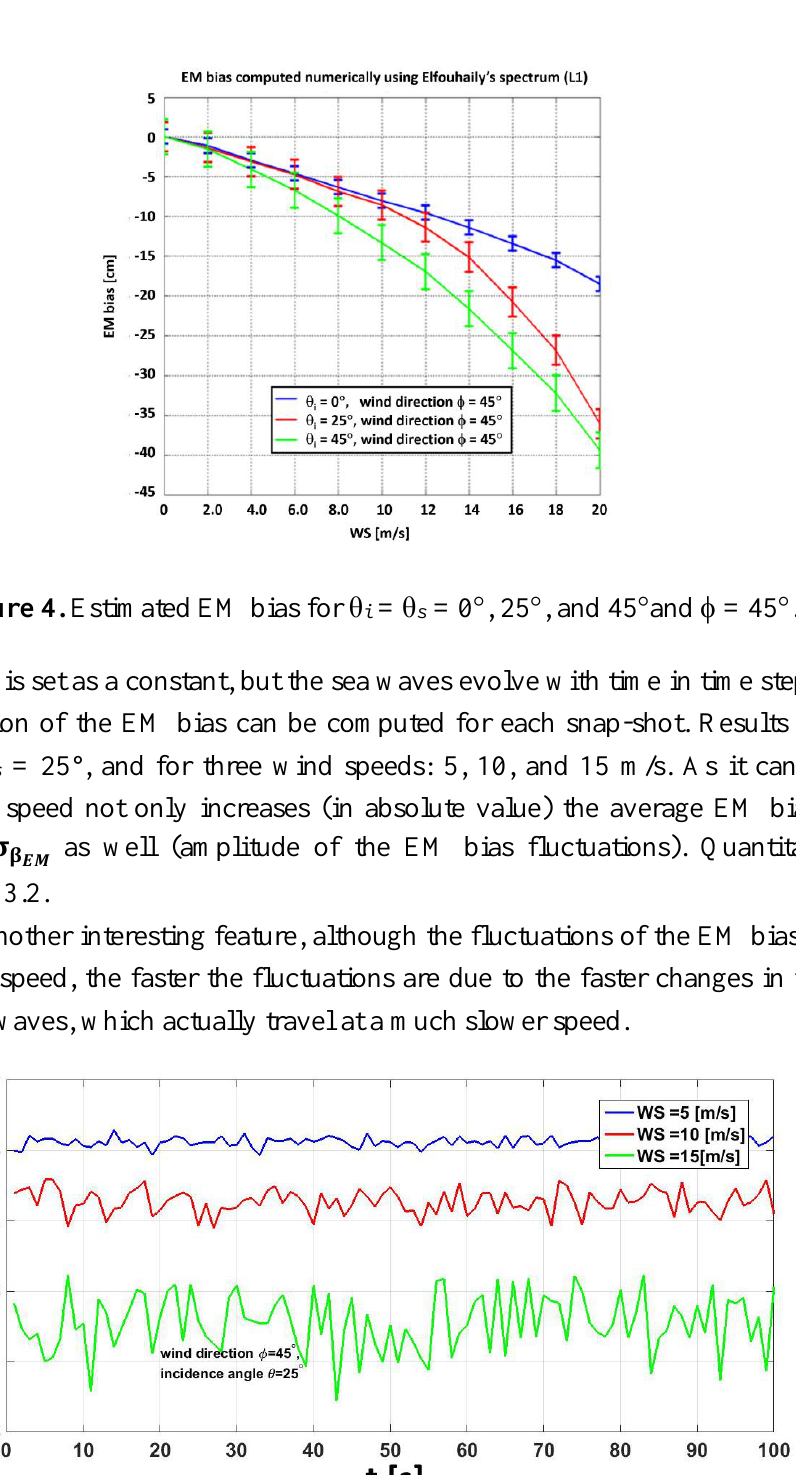
= θ s = 25°, and wind direction ϕ R R